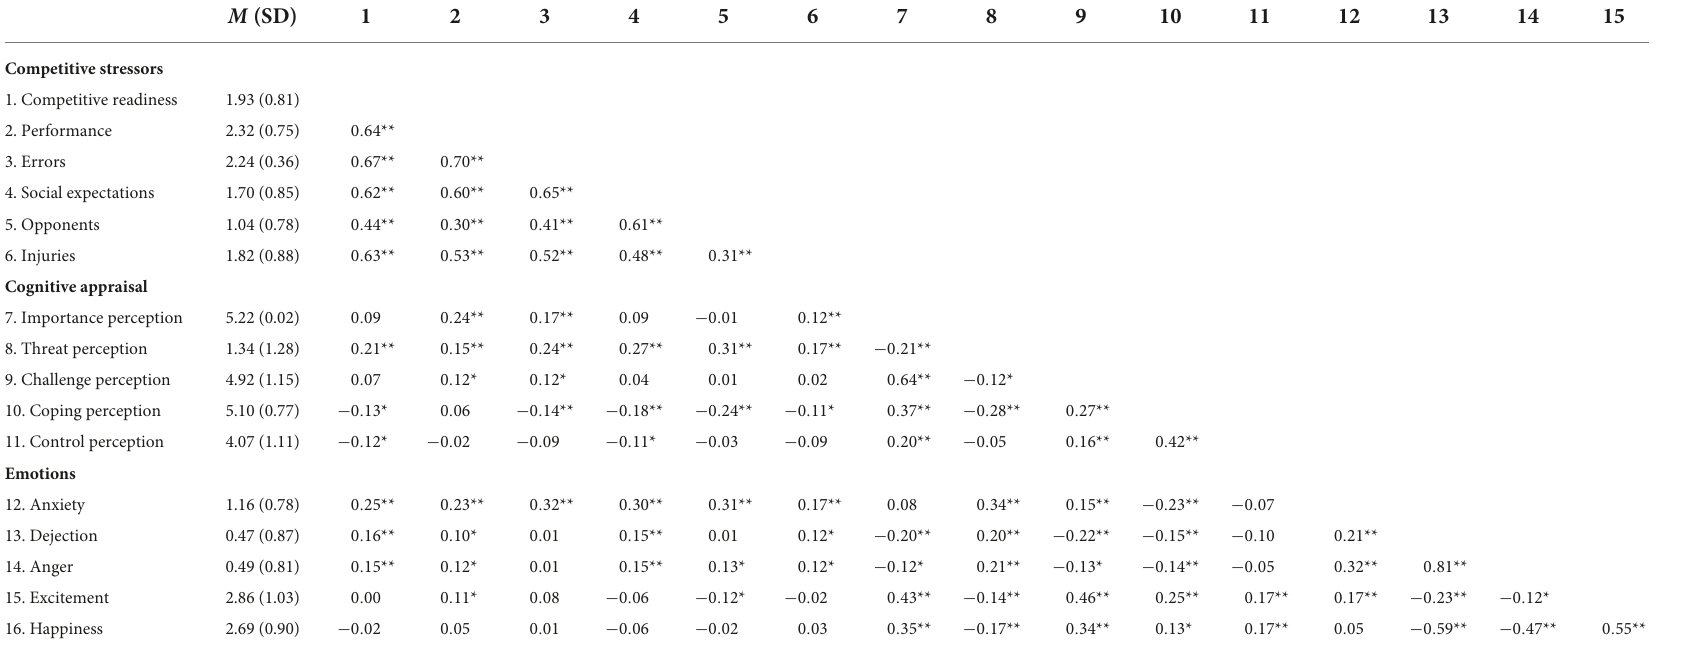
TABLE 1 Means (Standard deviations) and correlations among the study variables ( N =